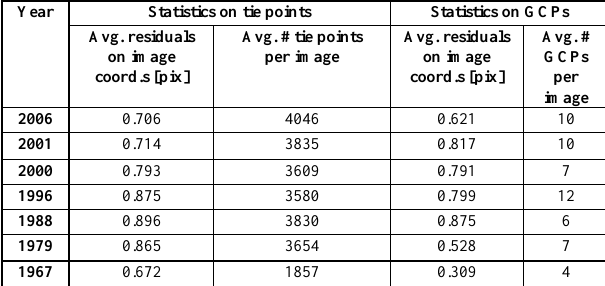
Table 3 . statistical parameters after BBA of different photogrammetric blocks.